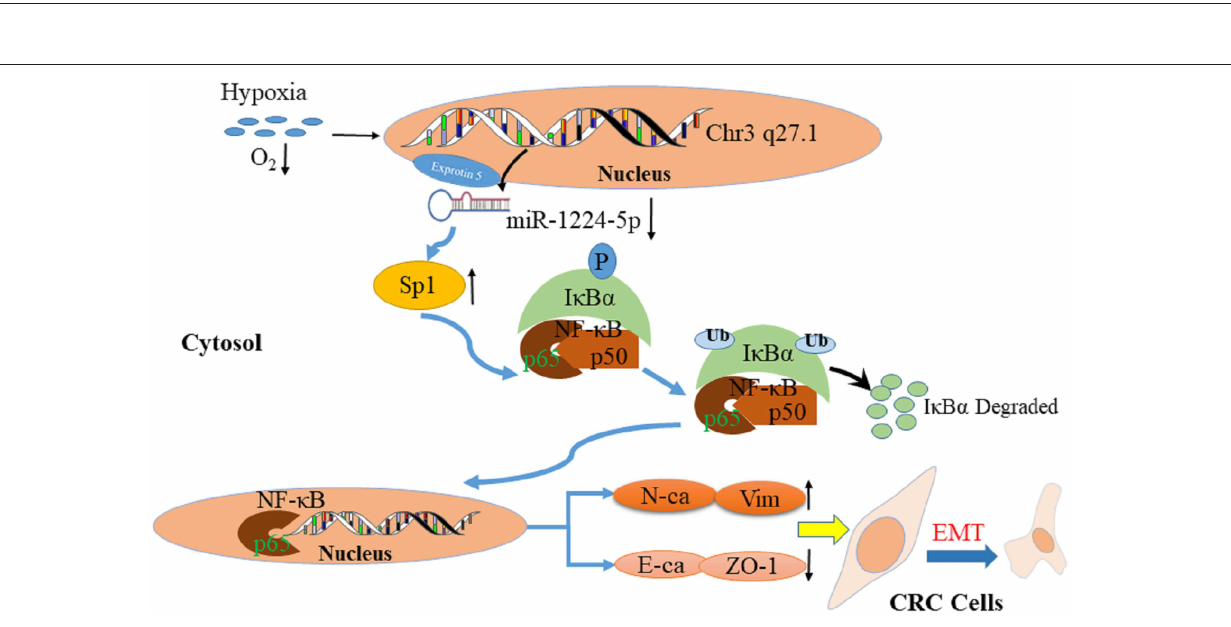
FIGURE 10 | revealed that hypoxia promoted migration and invasion of SW480 cells, while miR-1224-5p overexpression abolished the effects of hypoxia, scale bars: 100 µ m (C) and 300 µ m (D,E) . Hypoxia facilitated the EMT process of SW480 cells and miR-1224-5p restoration showed an opposite effect. (F) I κ B α ,